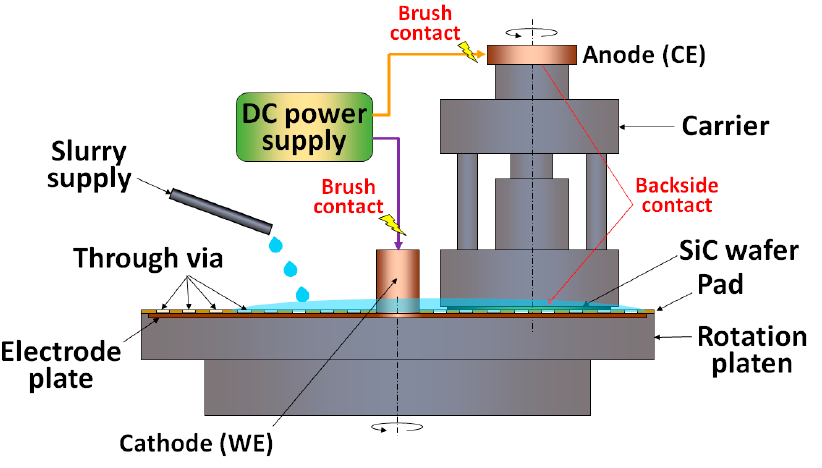
Figure 4. Typical setup for SiC ECMP.